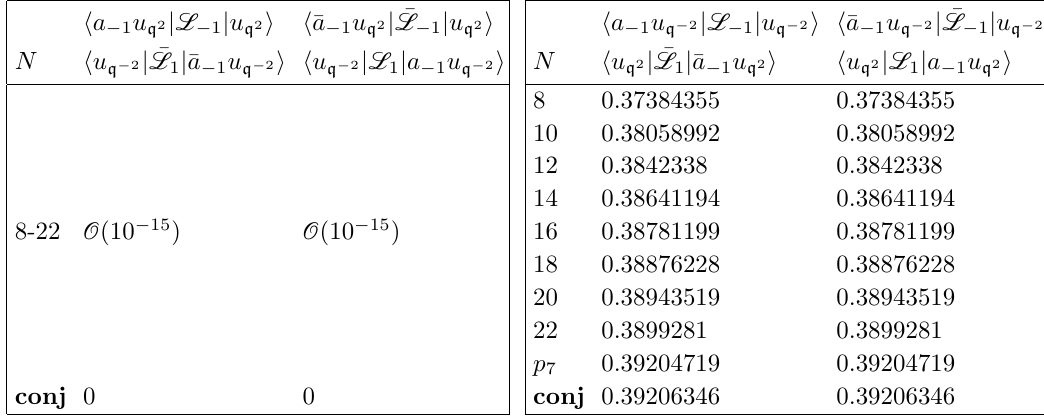
Table 10 . Matrix elements of L (cid:6) 1 and (cid:22) L (cid:6) 1 in the sector of S z = 0, at x = (cid:25) , j e j = 1 and twisted boundary conditions, with the same conventions as in table 3. We call j u at twisted boundary conditions e (cid:30) = (cid:11) (cid:0) =(cid:11) + , corresponding to the module W primary state at twisted boundary conditions e (cid:30) = (cid:0) (cid:11) (cid:0) =(cid:11) + , corresponding to the module W